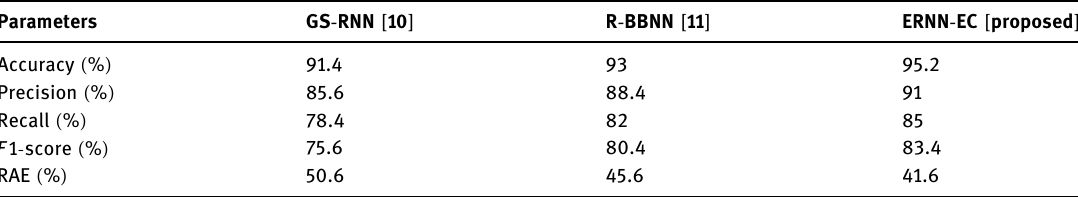
Table 8: Overall comparative analysis between existing and proposed methods